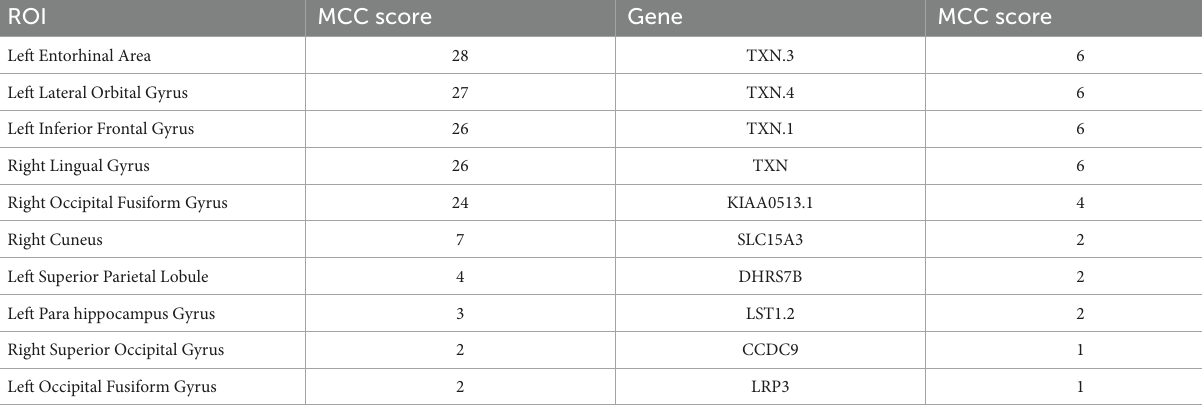
TABLE 6 Top 10 ROIs and genes and their MCC score information in MCI group. ROI MCC score Gene MCC